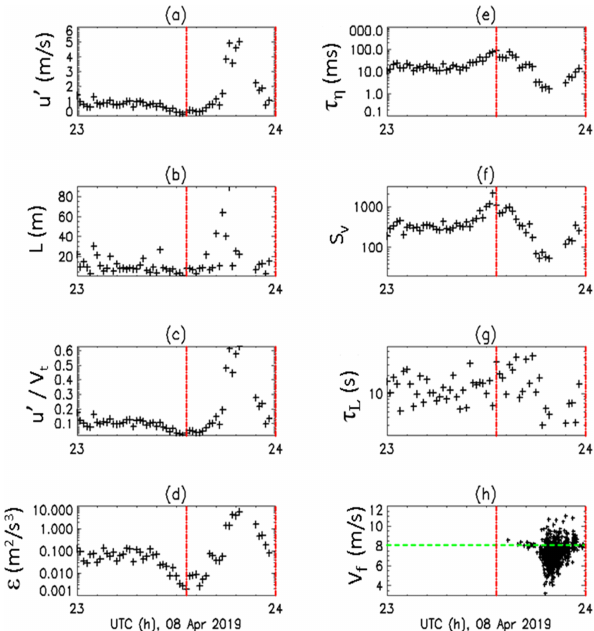
Figure 4. (a) to (g) show the pertinent quantities derived from the CSAT-3B 100Hz horizontal wind data (see text and Table 1 for de- tails) for the 8 April 2020 event from 23:00 to 24:00UTC; (h) mea- sured fall speeds for the 3mm drops from 2DVD-SN16 (black) and the expected fall velocity as green line. The two dashed red lines in all panels represent the time interval of